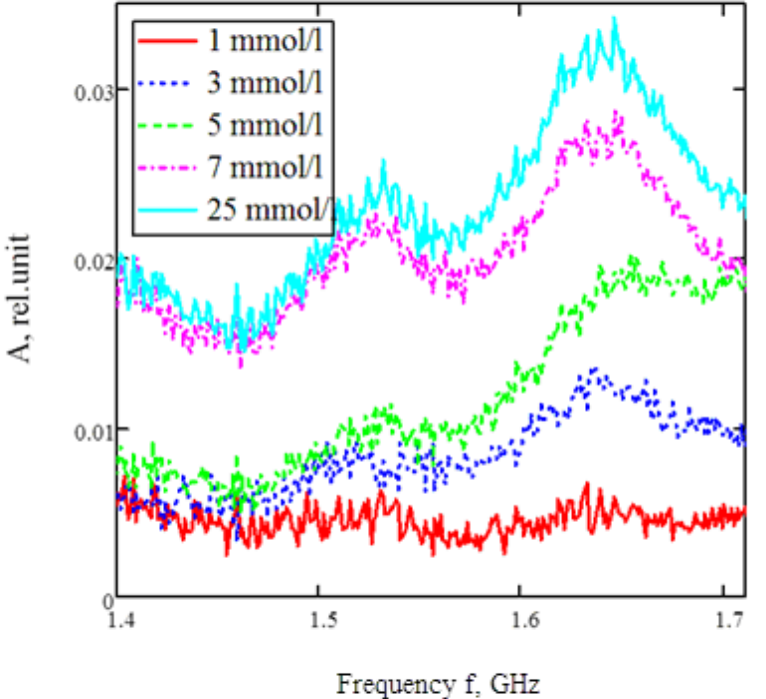
Figure 6. Modulus of the complex reflection coefficient for the indicated dextrose concentrations in the frequency range 1.4–1.7 the frequency range 1.4–1.7 GHz.